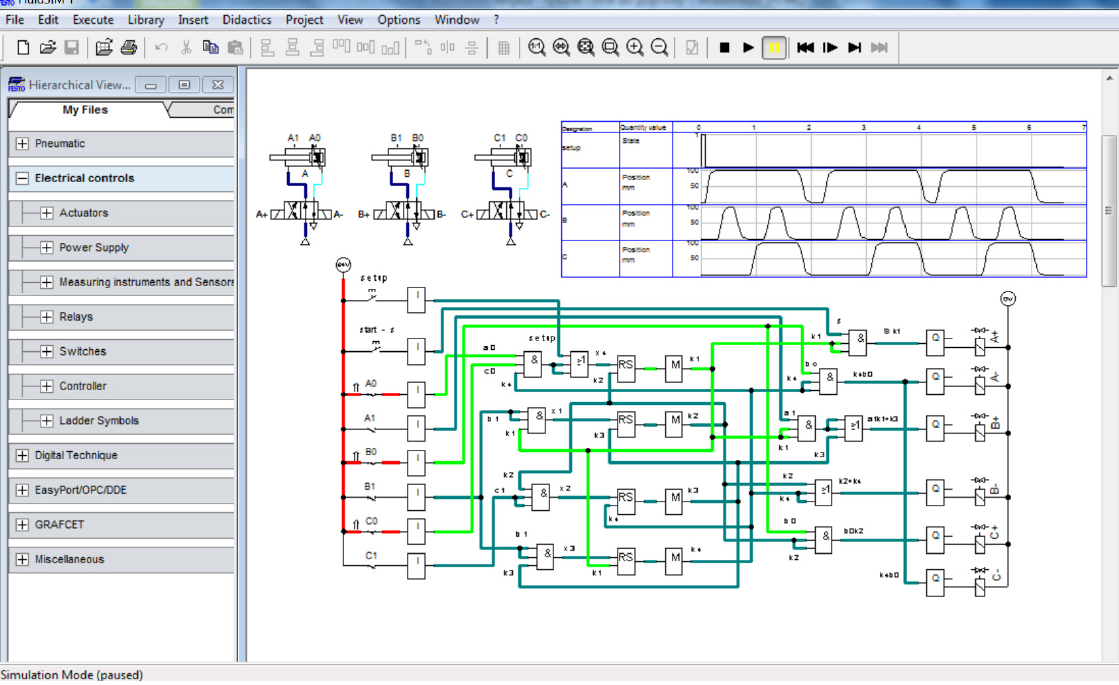
Figure 7. View of the program window during the simulation of the electro-pneumatic system.